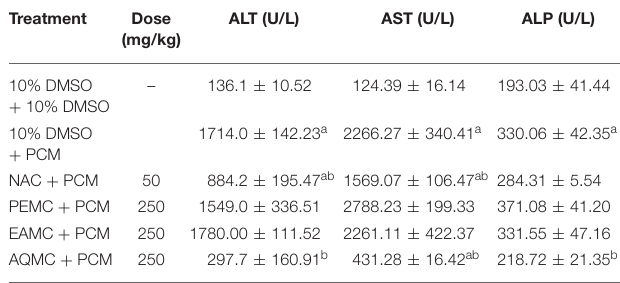
TABLE 4 | Effect of the orally administered PEMC, EAMC, or AQMC, at the dose of 250 mg/kg, on the level of serum liver biomarkers, namely alanine transferase (ALT), aspartate aminotransferase (AST), and alkaline phosphatase (ALP), of PCM-intoxicated